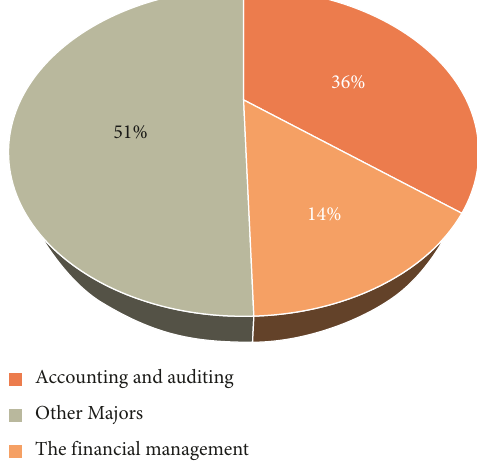
Figure 7: Professional background of auditors in an